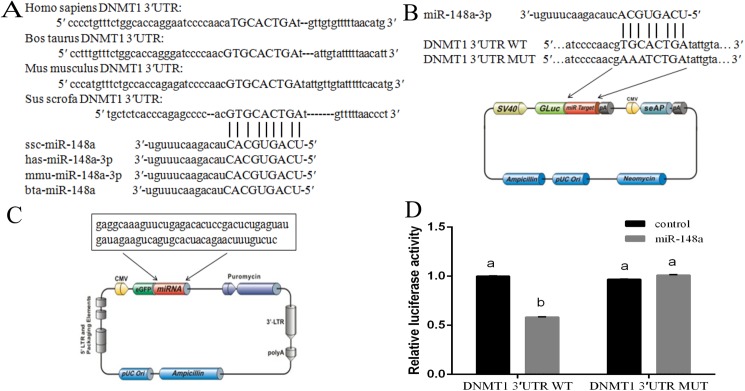
DNMT1 was target gene of miR-148a.(A) miR-148a is highly complementary to pig DNMT1 3'UTR. This potential miR-148a target site is conserved in human, cows, mice and pigs. (B) Schema contains WT and Mut 3-′UTRs of DNMT1, indicating the interaction sites between miR-148a and 3-′UTR of DNMT1. (C) Schema of miR-148a precursor sequence in pEZX-MR03. (D) Luciferase activities were measured in 293T cells co-transfected with the pEZX-DNMT1 (wild type or mutant) and pEZX-miR-148a or pEZX-miR-control. The data were reported as mean ± S.D. for three independent experiments (p < 0.05).